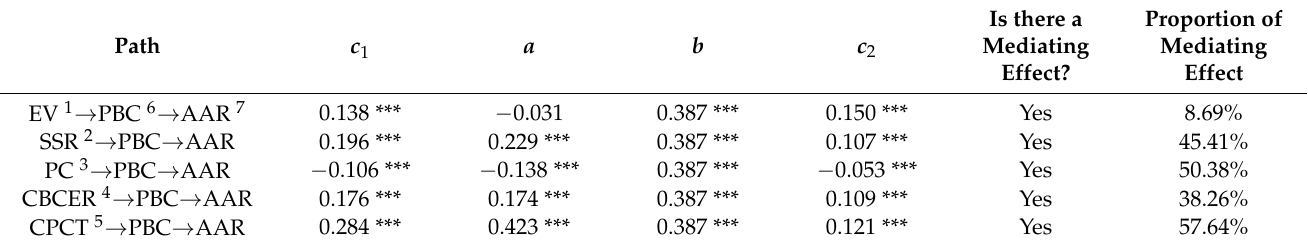
Table 6. Mediating effect test results of perceived behavioral